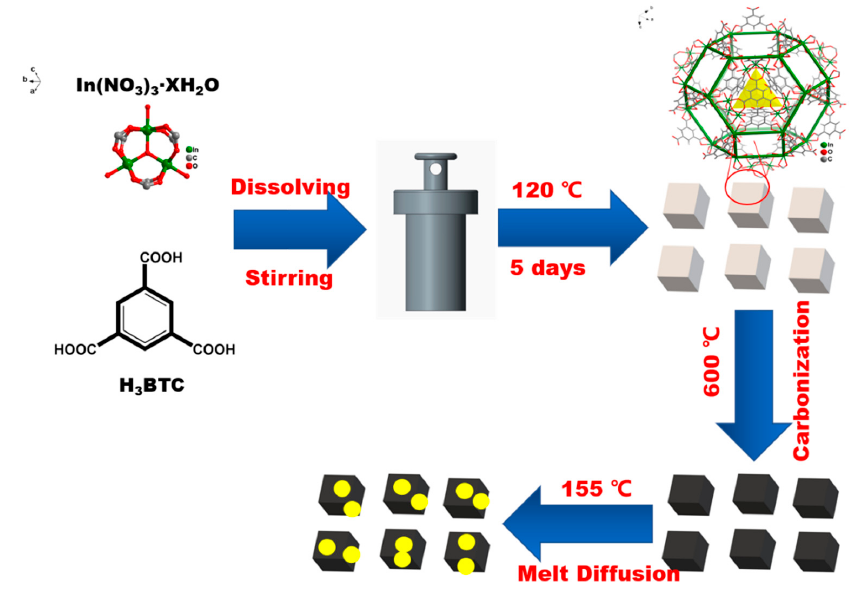
Figure 1. The Schematic illustration of the CPM-5-C-600@S composite preparation.